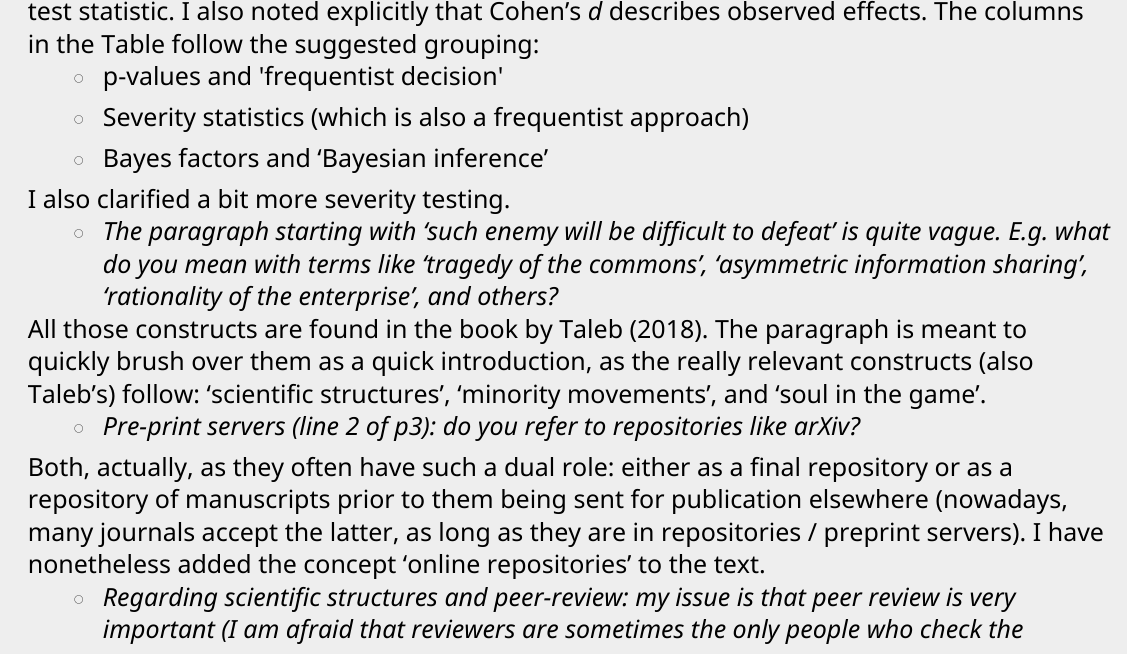
Table 1: too concise in my opinion. On what N are the p-valus based? Are the Cohen’s d values observed ones? A bit more information on severity tests might be useful. Perhaps columns that belong together (p and Decision; BF and Evidence; if I’m correct) may be put together more